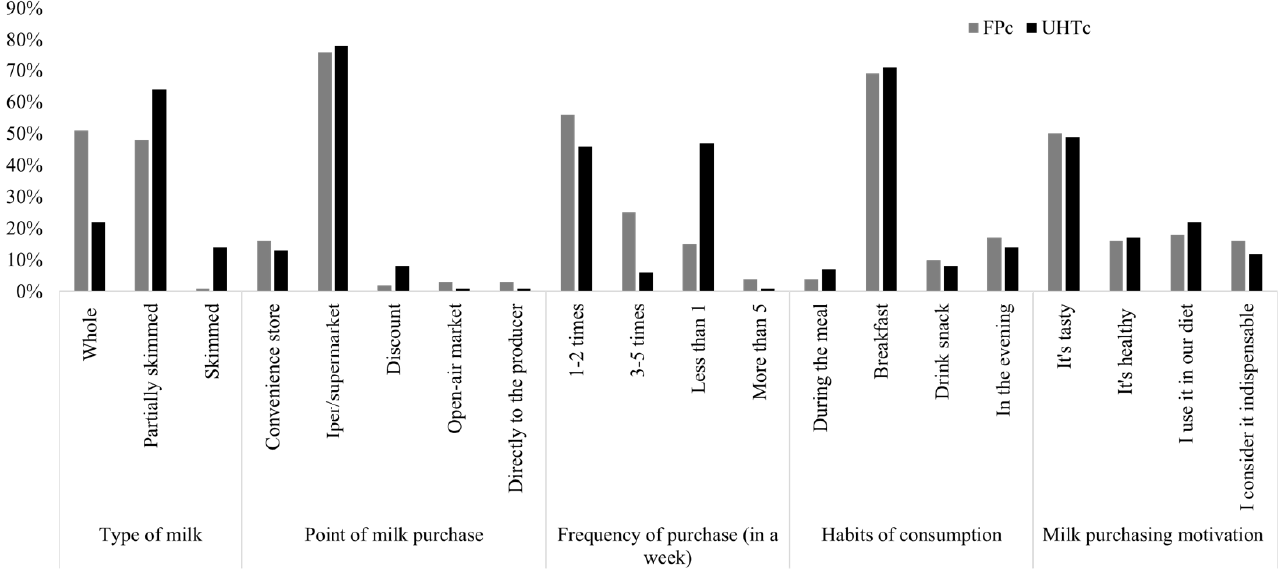
Figure 2. Milk purchasing and consumption habits of the two consumer groups: fresh pasteurized (FP c ) and UHT milk consumers (UHT c (FP c ) and UHT milk consumers (UHT c ).